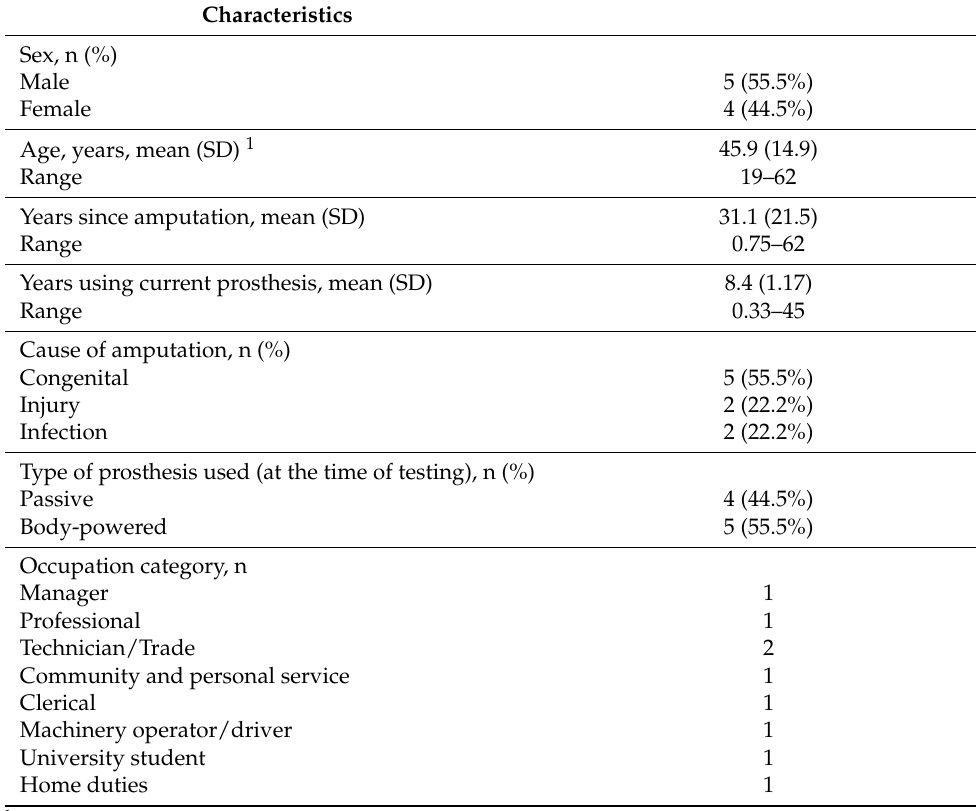
Table 1. Demographic and clinical characteristics (N = 9).